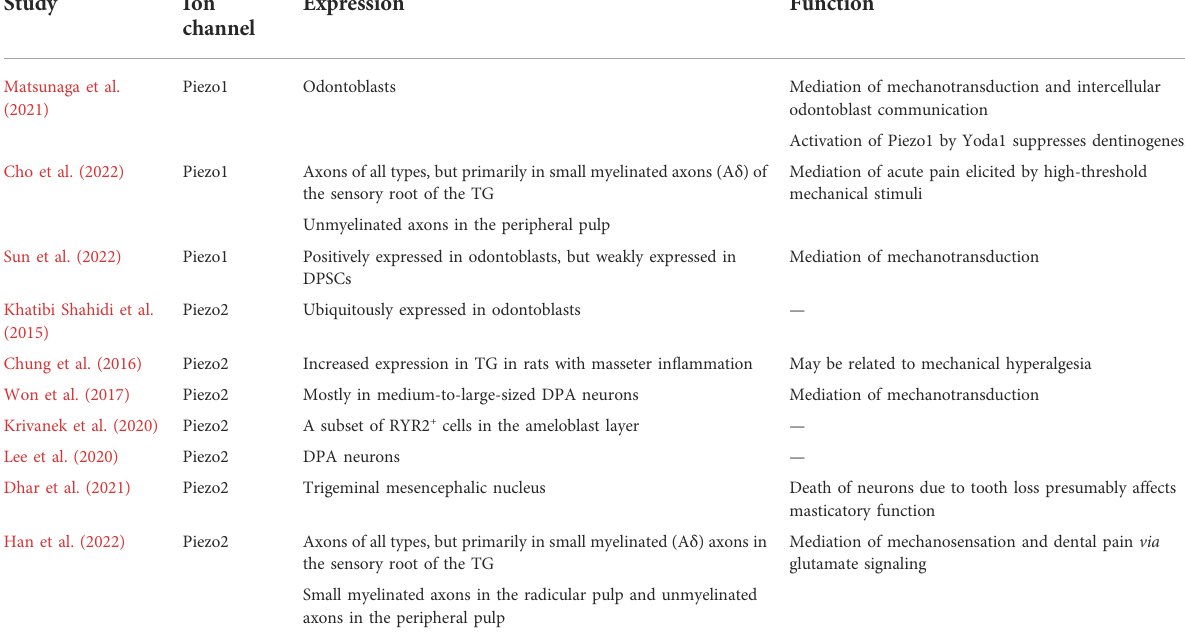
TABLE 1 The expression and function of Piezo ion channels in the mechanotransduction of dental sensation.